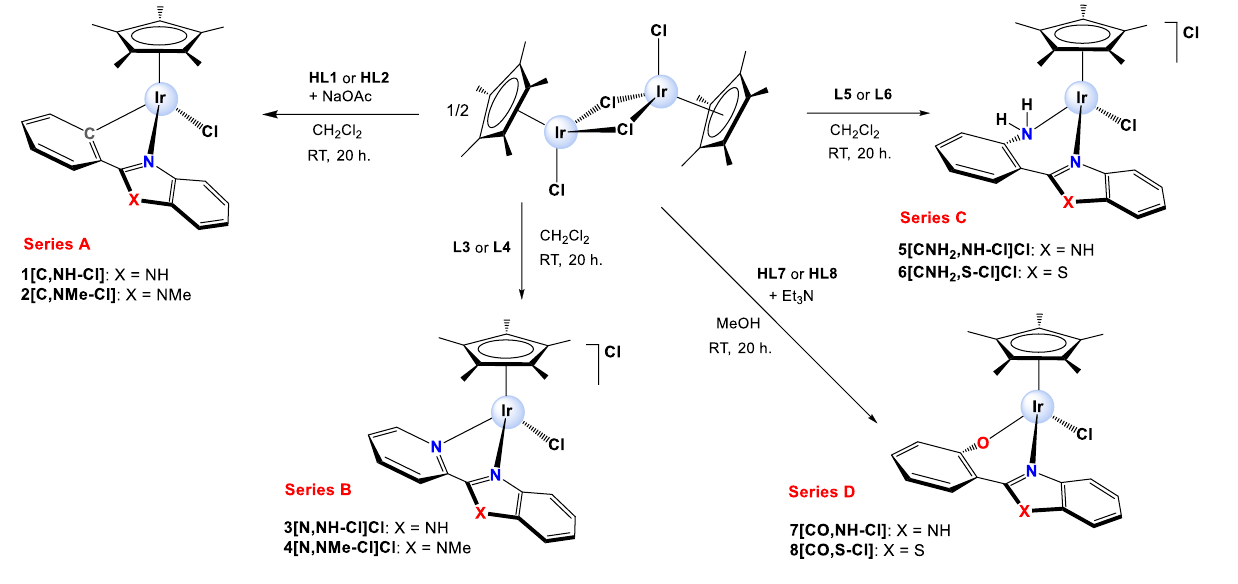
Figure 3. Schematic synthesis of the studied half-sandwich Iridium(III)